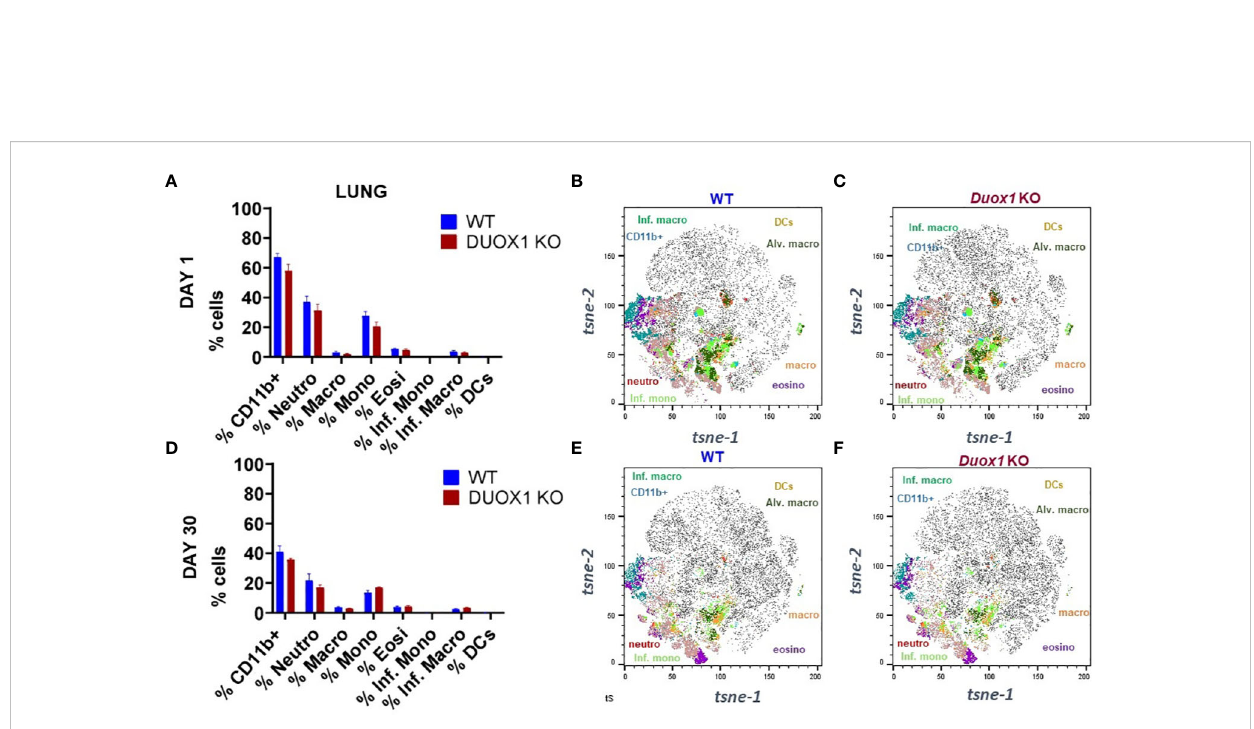
FIGURE 4 Myeloid cell populations in the lung tissues of Mtb -infected WT and Duox1 KO mice. (A) Mean observed cell proportions determined by fl ow cytometry in lung lysates from two independent experiments (n= 5 per mouse genotype) of Mtb -infected WT mice at 1 day post-infection. (B) Marker expression by t-sne in Mtb -infected WT mice at 1 day post-infection. (C-F) Marker expressions by t-sne in Mtb -infected Duox1 KO and WT mice at 1 and 30 day(s) post-infection as indicated. Duox1 KO, Duox1 -de fi cient; WT,